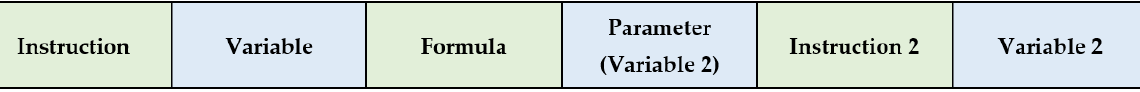
Figure 3. Syntax instruction structure diagram.